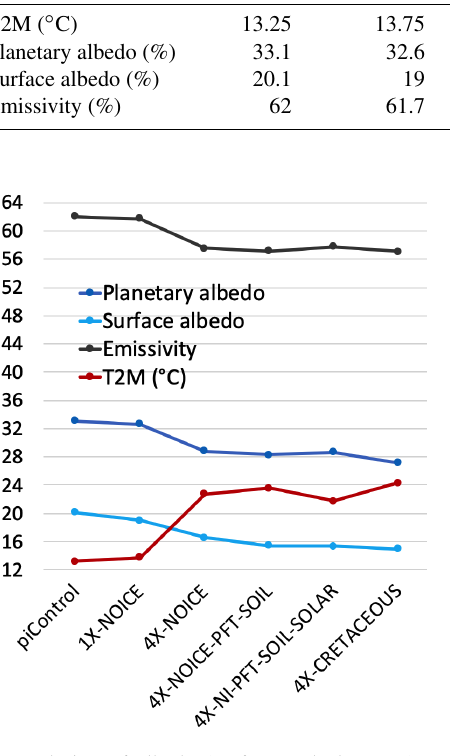
Figure 3. Evolution of albedo (surface and planetary) and emis- sivity, in percentages and of T2M ( ◦ C) from piControl to 4X- CRETACEOUS simulations. The major change is always recorded with the change in p CO 2 between 1X-NOICE and 4X-NOICE sim- ulations.